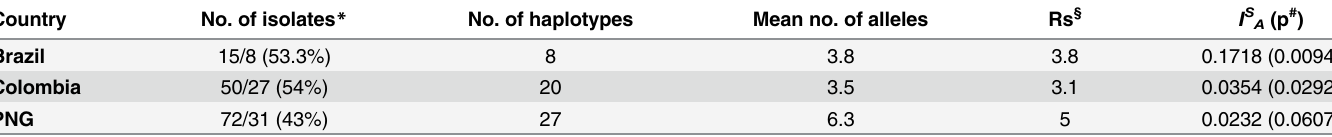
Table 3. Allelic richness (Rs) and LD ( I S A ) of analyzed Plasmodium falciparum populations.